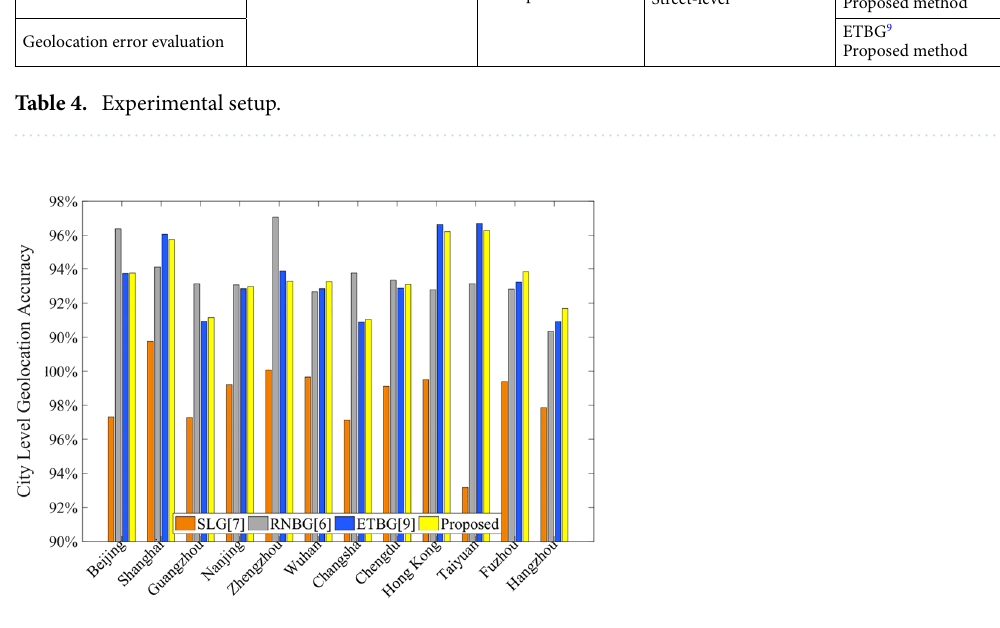
Figure 4. Comparison of city-level geolocation